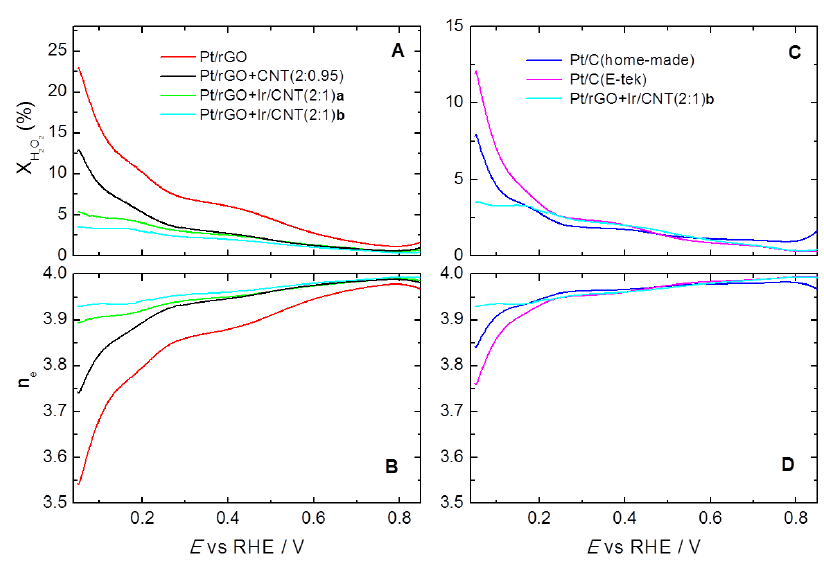
Figure 6. Formation of ( A , C ) the hydrogen peroxide intermediate and ( B , D ) number of exchanged electrons during oxygen reduction under conditions of rotating ring – disk electrode (RRDE) voltammetric experiments in Figure 5.